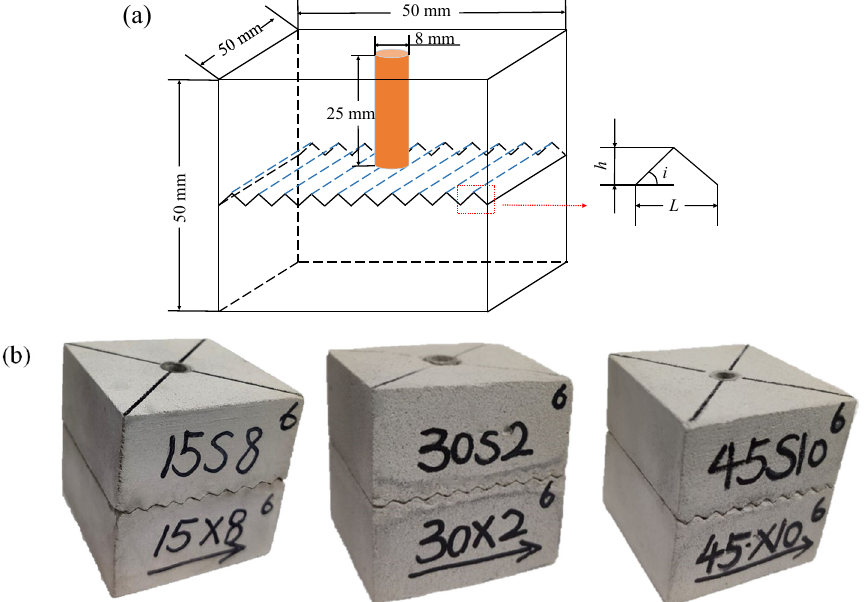
Figure 1. Illustration of the ( a ) geometric and ( b ) physical models of the structural planes that were